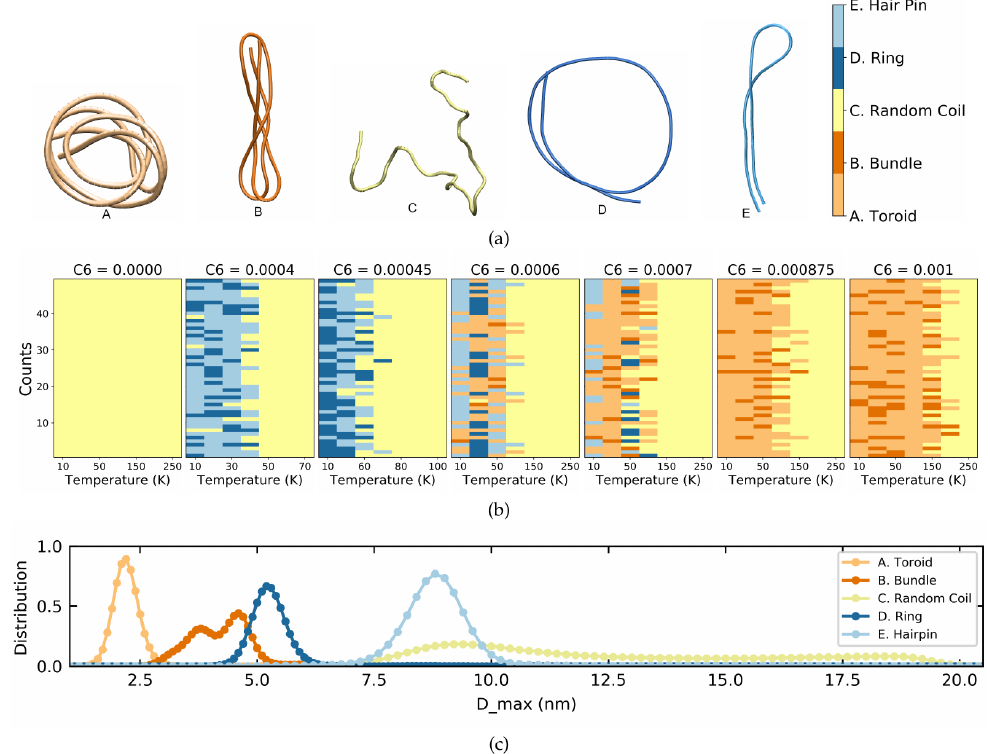
Figure 4. ( a ) From left to right illustration of toroid, bundle, random coil, ring and hairpin. ( b ) Color coded final conformations at a range of temperature for 50 simulations at different C 6 values. ( c ) D max distribution of the above five mentioned